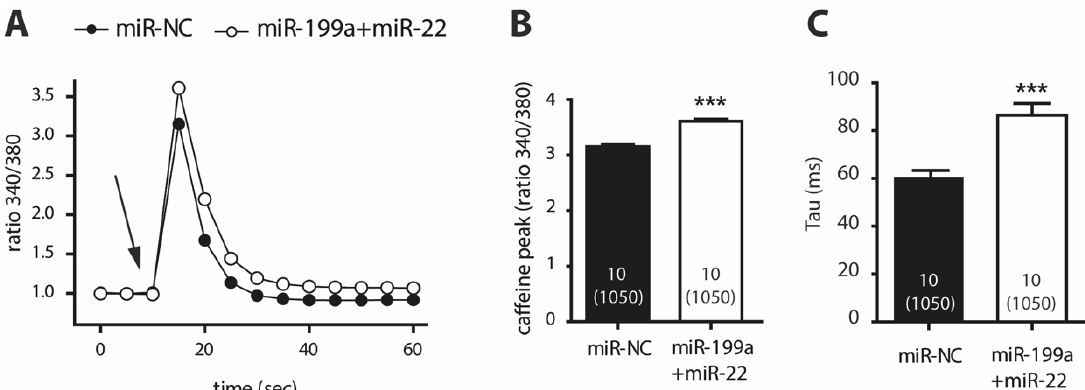
Figure 4. Caffeine-induced calcium response in HL-1 cells transfected with miR-199a+miR-22 (white) or miR-NC (black) ( A ). Normalized intracellular calcium fluctuations with the application of 10 mM caffeine (arrow). To assess caffeine-induced maximum peak, basal calcium levels in both transfection conditions were normalized to one ( B ). Maximum calcium levels post-caffeine graphed and averaged in column bars ( C ). Calcium decay expressed as the time constant, Tau. *** p < 0.0001. Number within the column represents the number of independent experiments performed with the total number of cells analyzed in parenthesis.